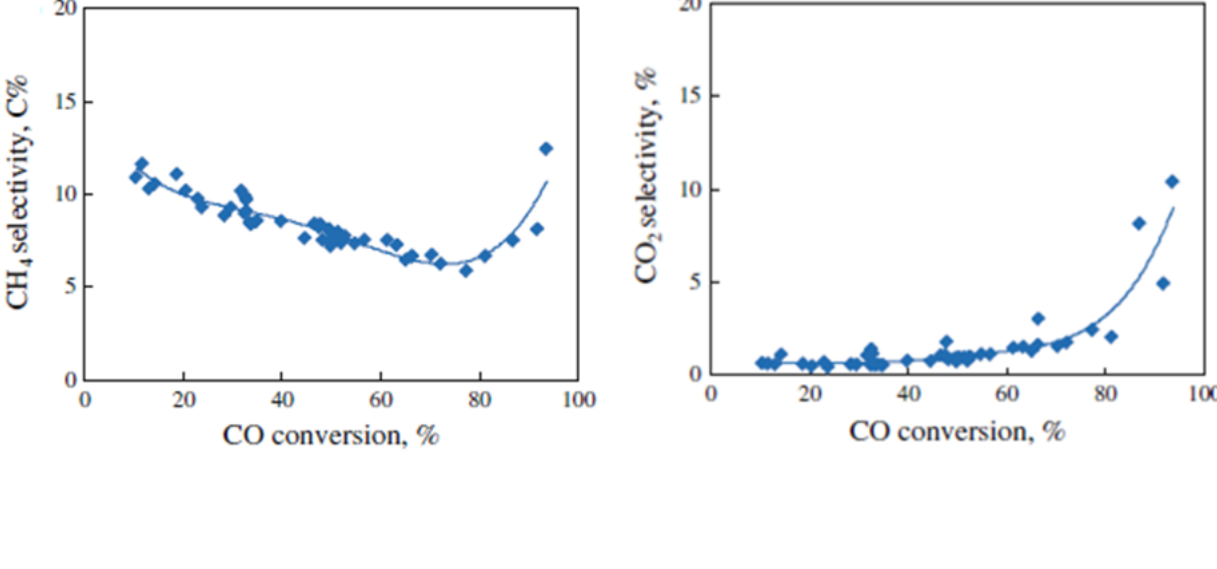
h (reproduced with cat